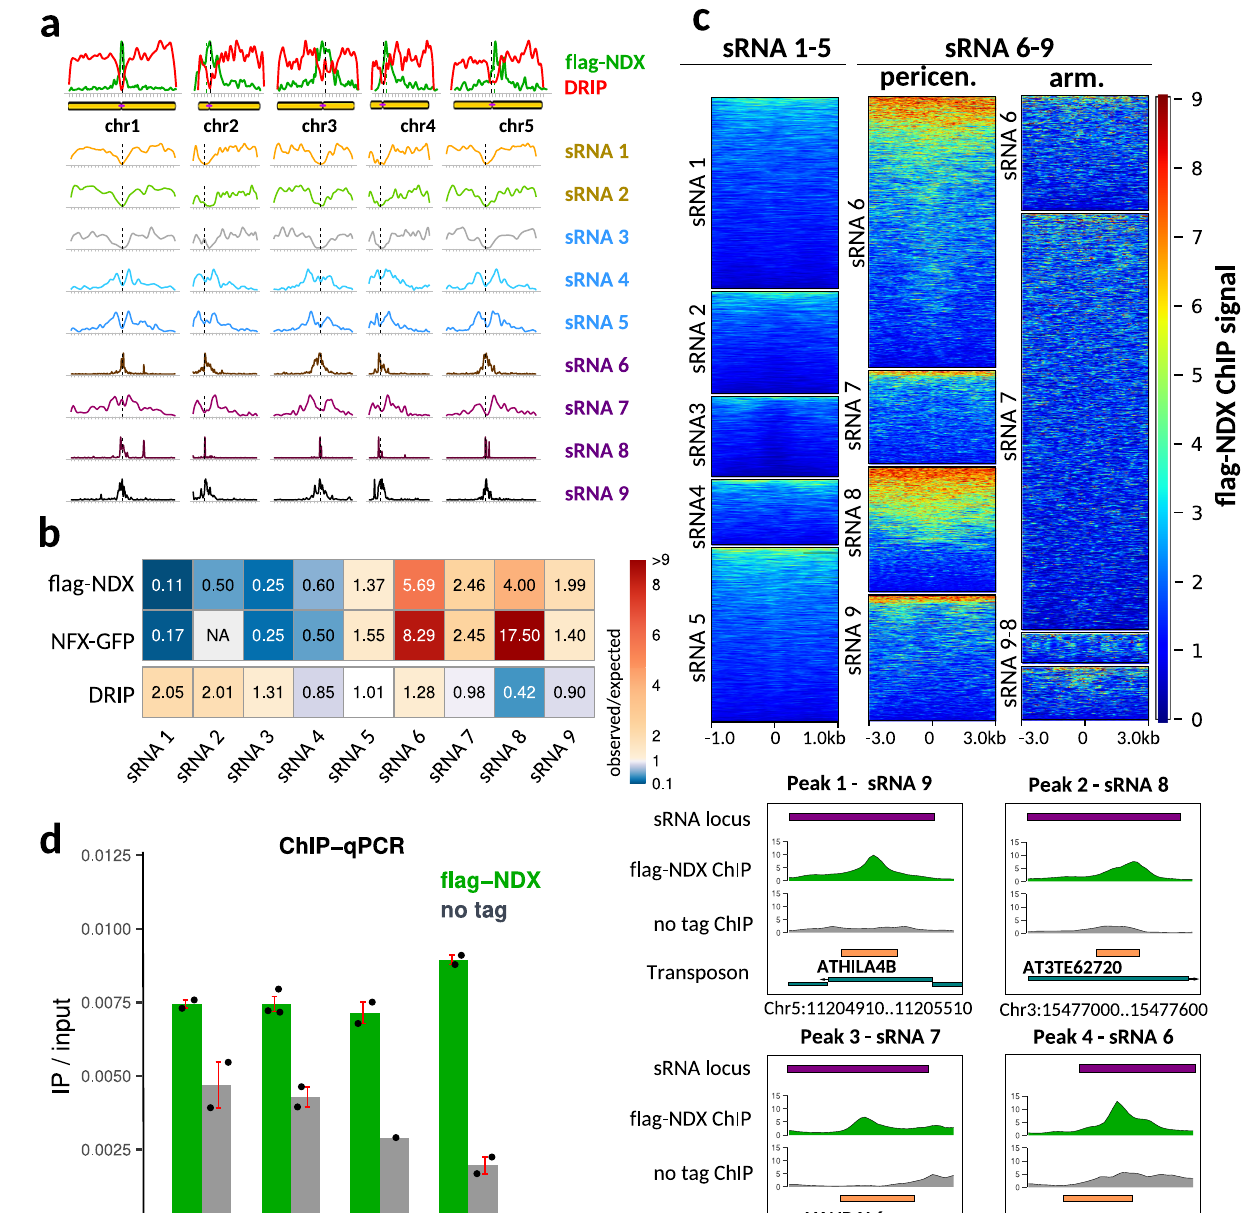
Fig. 5 | NDX binds to heterochromatic small RNA loci (het-siRNA). a Chromosomal distribution of fl ag-NDX binding sites (green), RNA-DNA hybrids (red),andsmallRNAloci.sRNAlociareclassi fi edintoninefunctionalclustersbased on their genetic and epigenetic relationships and expression pro fi les 51 . NDX- binding sitescorrelate withcluster6 – 9 sRNAlociwhile R-loops arecorrelated with cluster 1 – 2 sRNA loci. b Overlap of fl ag-NDX, NDX-GFP, and DRIP peaks with sRNA clustersrelativetorandomassociations.Cellscontainobserved/expectedratiosfor peak counts. Warmer colors indicate higher degree of association. c Metaplot